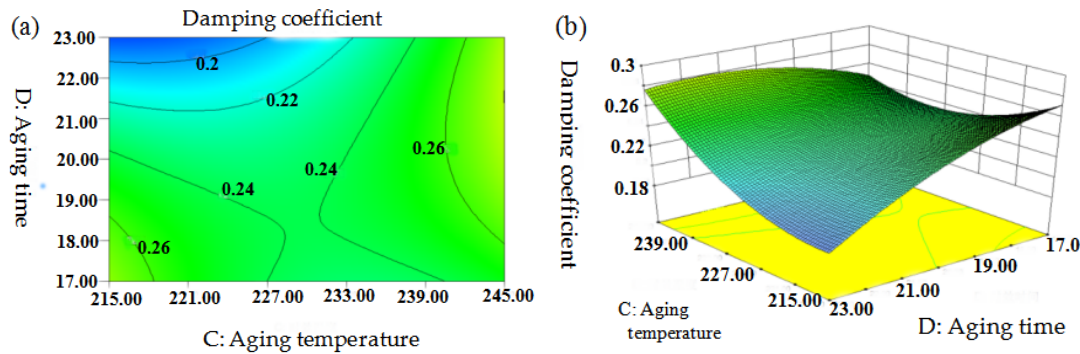
Figure 16. Interaction between ageing temperature and solution time versus the damping coefficient. ( a ) contour map; ( b ) surface response map.